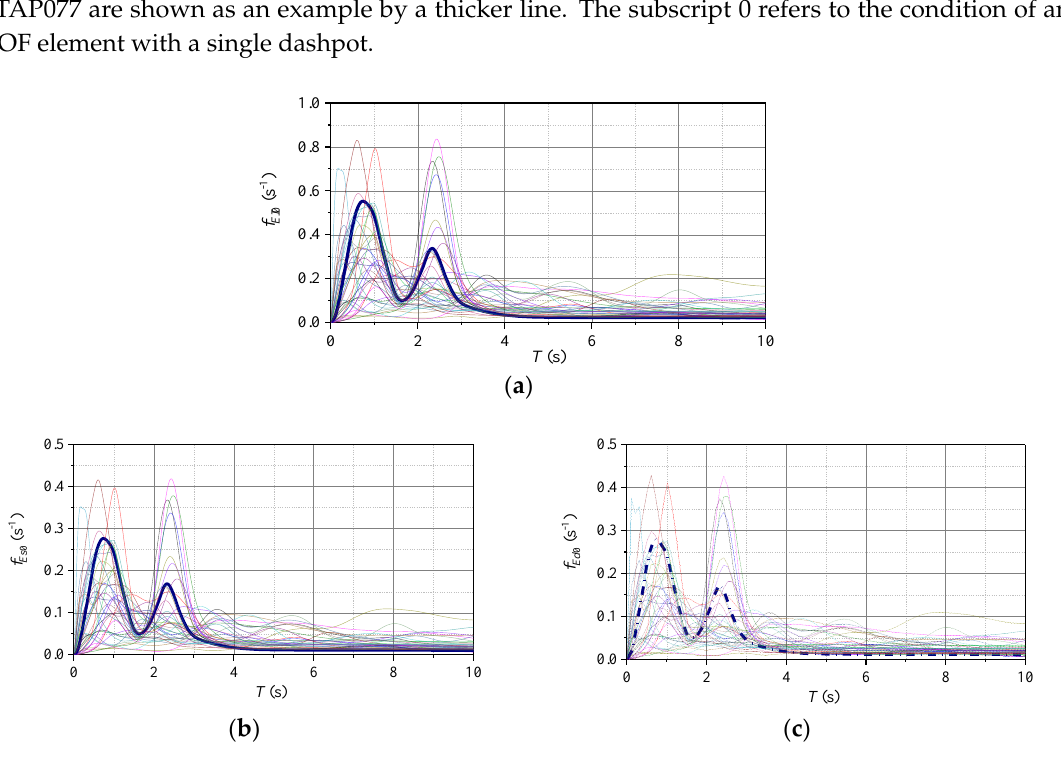
Figure 14. Normalized seismic-induced energy spectra of SDOF element connected to a single dashpot. ( a ) Input energy spectra of SDOF element connected to a single dashpot. ( b ) Dissipated energy spectra of primary SDOF element. ( c ) Dissipated energy spectra of single dashpot.